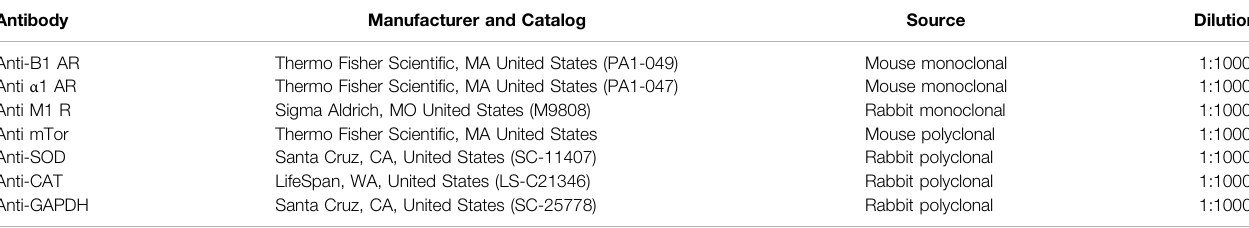
TABLE 2 | List of antibodies used for western immunoblotting. Antibody